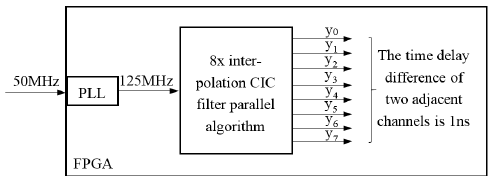
Figure 5. The ultrasonic phased array focusing time delay system based on 8 × interpolation CIC filter parallel algorithm.